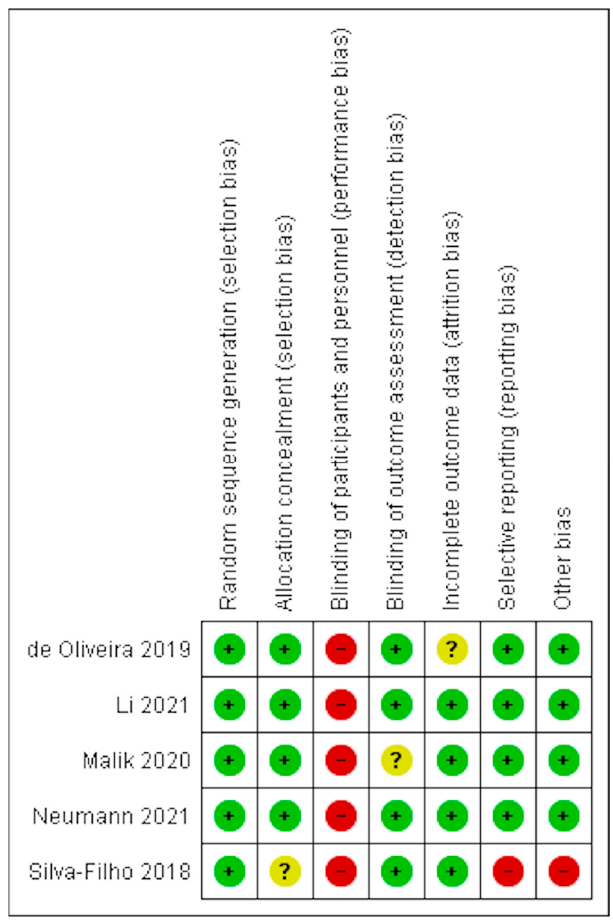
Figure 2. Risk of bias [13,90–93] (Legend: +: Low risk, -: High risk & ?: Unclear risk).